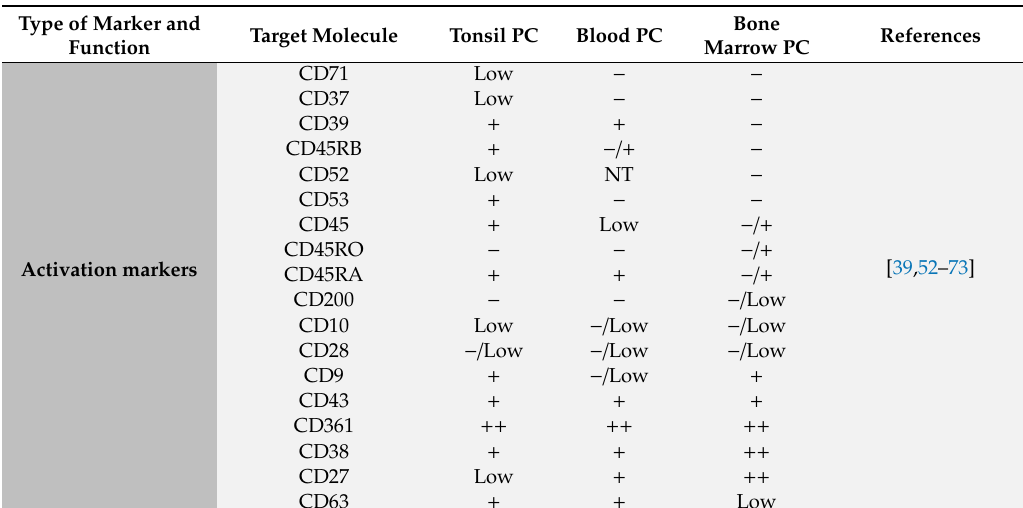
Table 1. Immunophenotypic profile of normal PC populations in secondary lymphoid tissues (e.g., tonsils), blood and bone